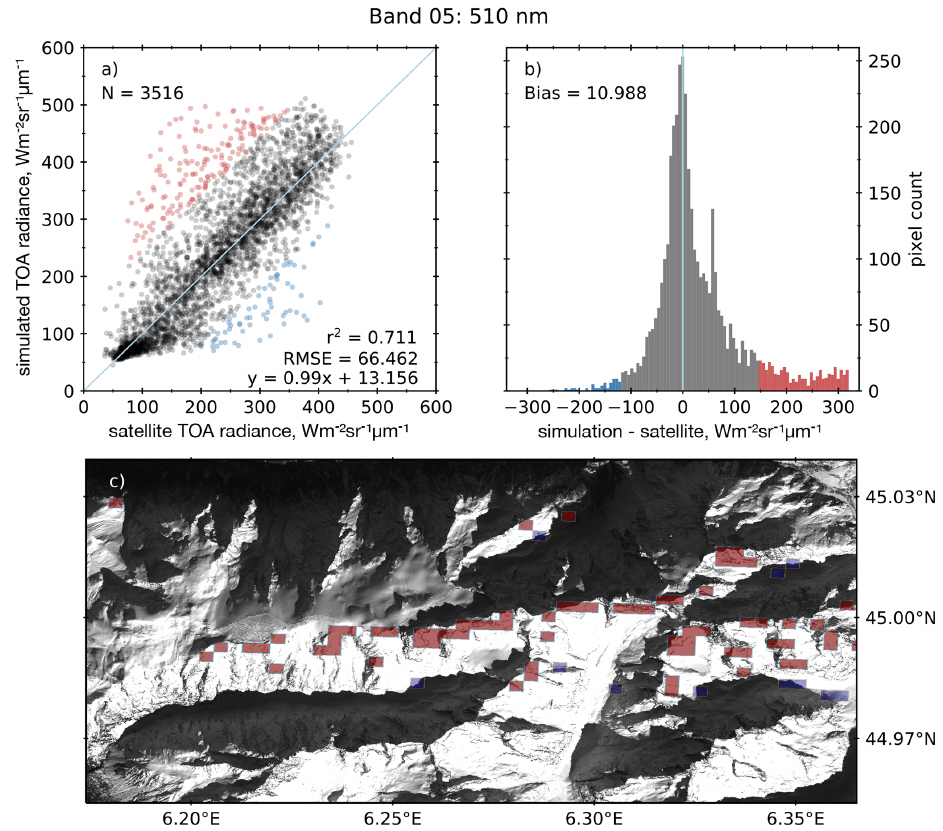
Figure 5. TOA radiance spectra computed with the rugged-terrain model and observed with OLCI at 510nm (band 05) on 13 February 2018. (a) Scatterplot of the relationship between the simulated TOA radiance and the concurrent satellite observations over the study area. The coloured points (red and blue) represent values under- or overestimated by more than 2 σ of the bias. (b) Difference between simulation and observation across the scene. (c) Spatial distribution of the under- and overestimated pixels shown on a 1.25m resolution SPOT 6 image, acquired on 19 February 2018 at 10:04UTC via the Kalideos Alpes project (©AIRBUS